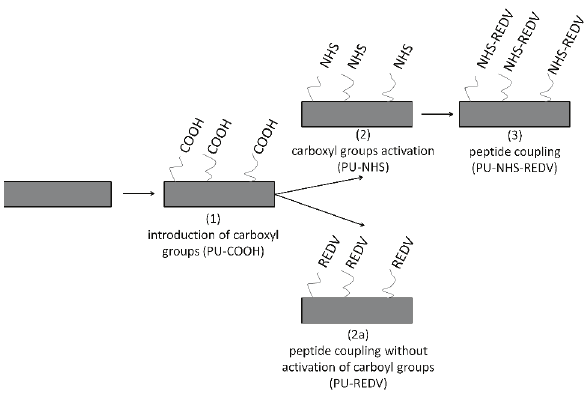
Figure 2 : Schematic representation of the preparation of PU-REDV materials.